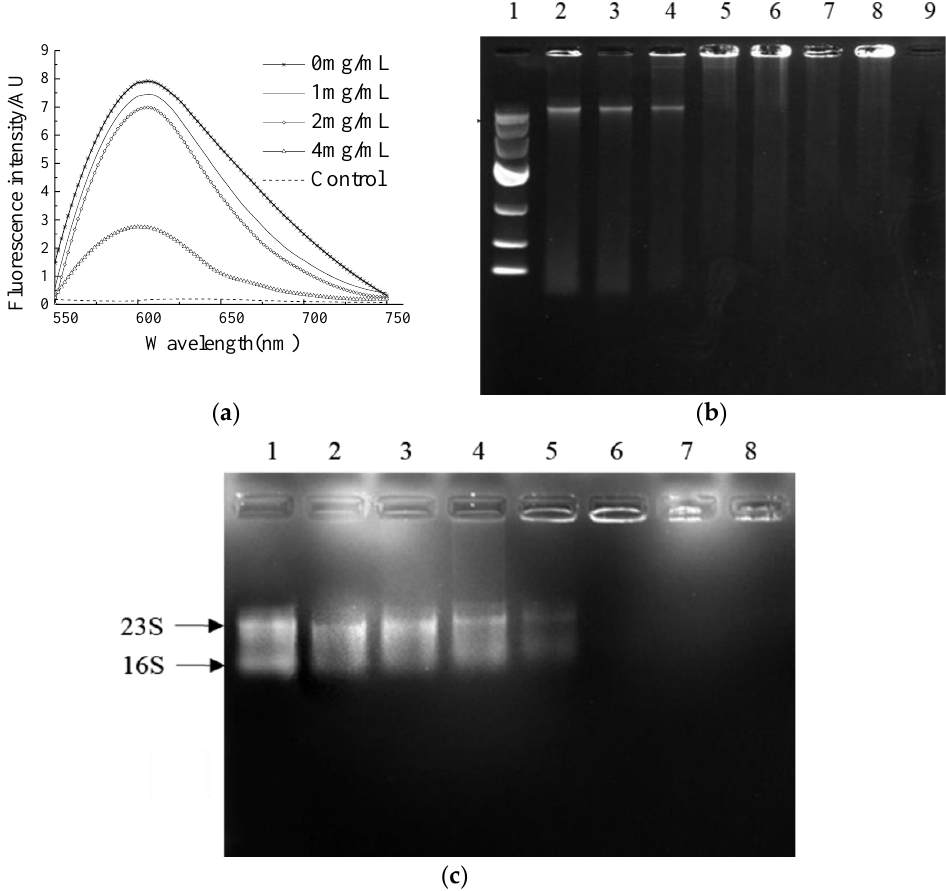
Figure 4. The binding ability of NP-6 with bacterial DNA/RNA. ( a ) Competitive binding of NP-6 and EB with S. aureus genomic DNA. Fluorescence spectra were measured from 550 to 750 nm; ( b ) Agarose gel electrophoresis of peptide and bacterial genomic DNA. Lane 1: DNA marker; lane 2: control, without peptide; lane 3: 0.1 mg/mL peptide; lane 4: 0.2 mg/mL peptide; lane 5: 0.4 mg/mL peptide; lane 6: 0.8 mg/mL peptide; lane 7: 1.0 mg/mL peptide; lane 8: 2.0 mg/mL peptide; lane 9: 4.0 mg/mL peptide; ( c ) Agarose gel electrophoresis of peptide and bacterial RNA. Lane 1: control, without peptide; lane 2: 0.1 mg/mL peptide; lane 3: 0.2 mg/mL peptide; lane 4: 0.4 mg/mL peptide; lane 5: 0.8 mg/mL peptide; lane 6: 1.0 mg/mL peptide; lane 7: 2.0 mg/mL peptide; lane 8: 4.0 mg/mL peptide.